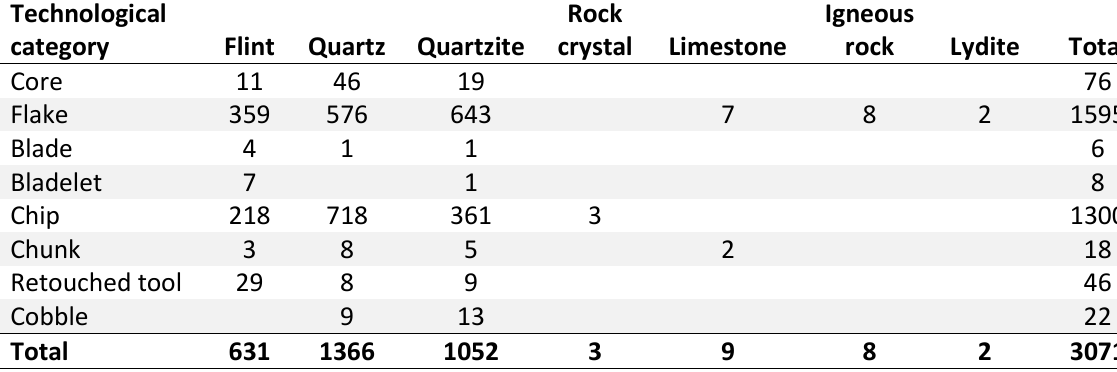
Table 2. Technological categories and raw material types present in the layer 14 sample. For quartz and quartzite, technological categories are given according to field